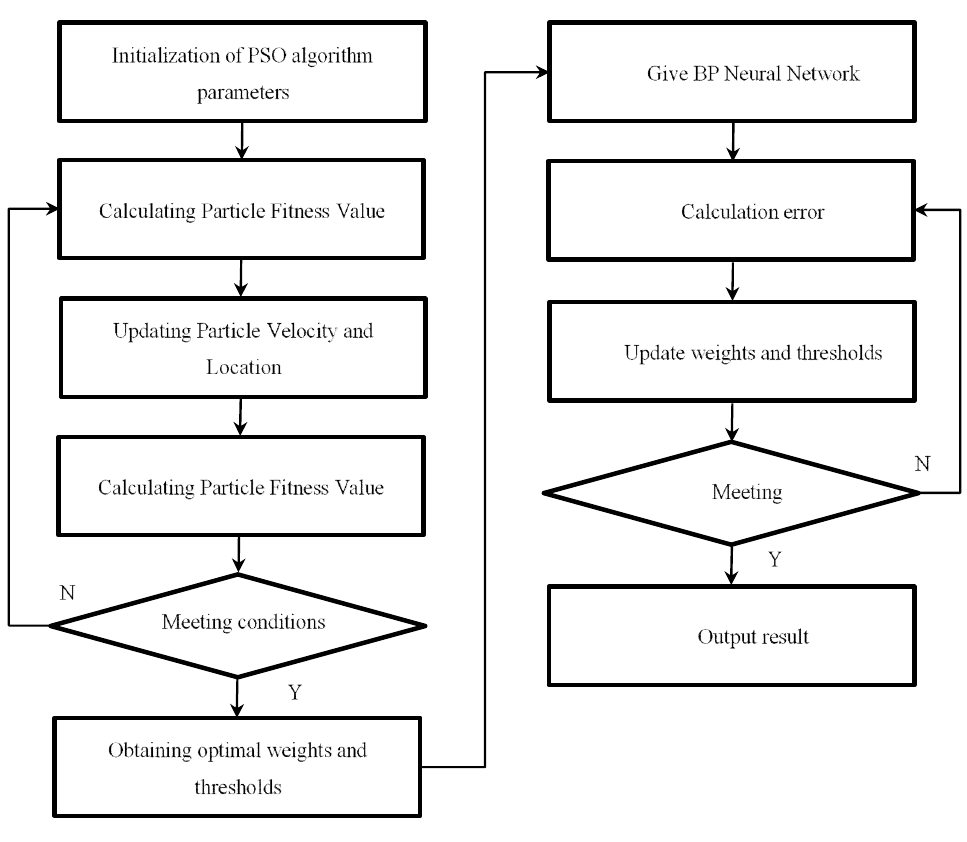
Figure 1. Flow chart of IPSO-BP